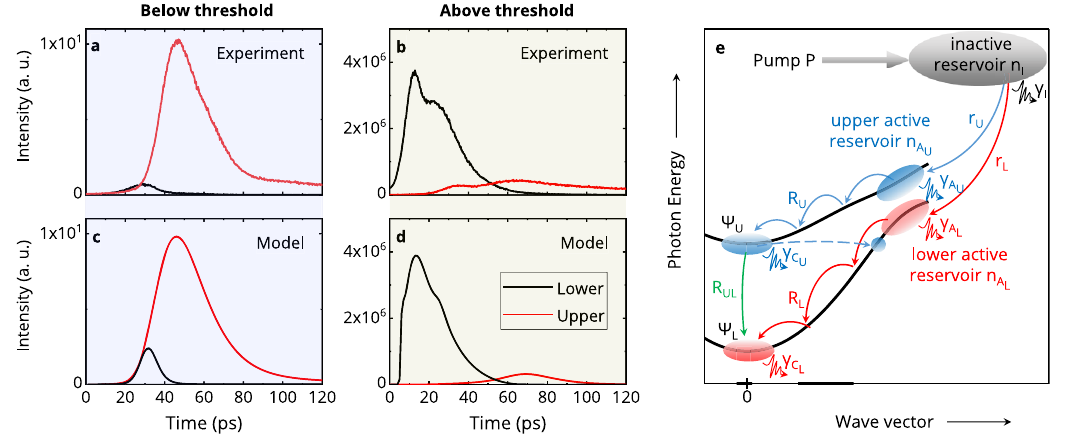
Figure 5: (a) and (b) Experimental and (c) and (d) calculated emission dynamics of the upper (red line) and the lower (black line) polariton , while for the spectra in level at k ∥ = 0. The spectra shown in (a) and (c) are acquired and calculated for an excitation power density of 0.8 P th panels (b) and (d) the excitation power density is 6.4 P . (e) Schematic-level diagram of the two lowest polariton branches emerging in a th vertically coupled, double microcavities structure. Transitions included in our open-dissipative Gross–Pitaevskii equation-based model are indicated and described in the